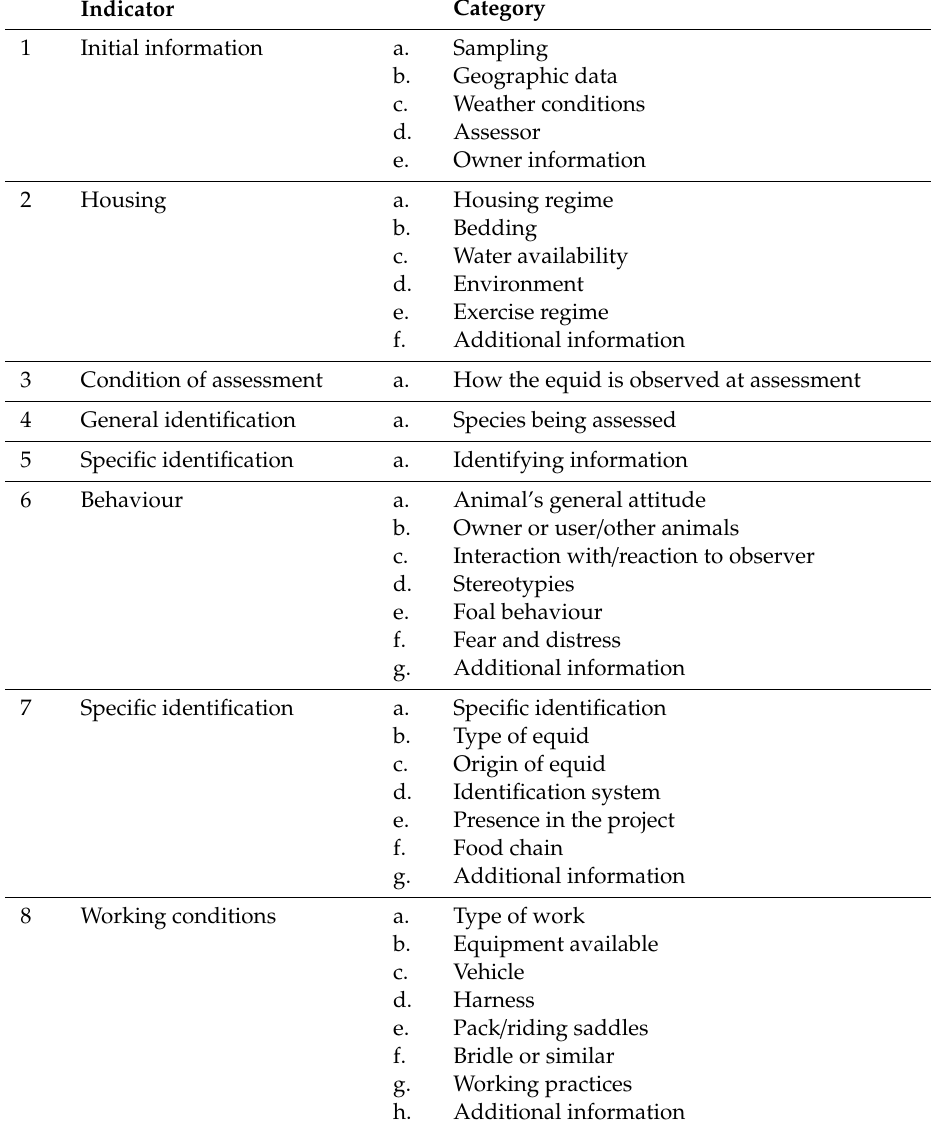
Table 1. List of the welfare indicators included in the Equid Assessment, Research and Scoping (EARS)